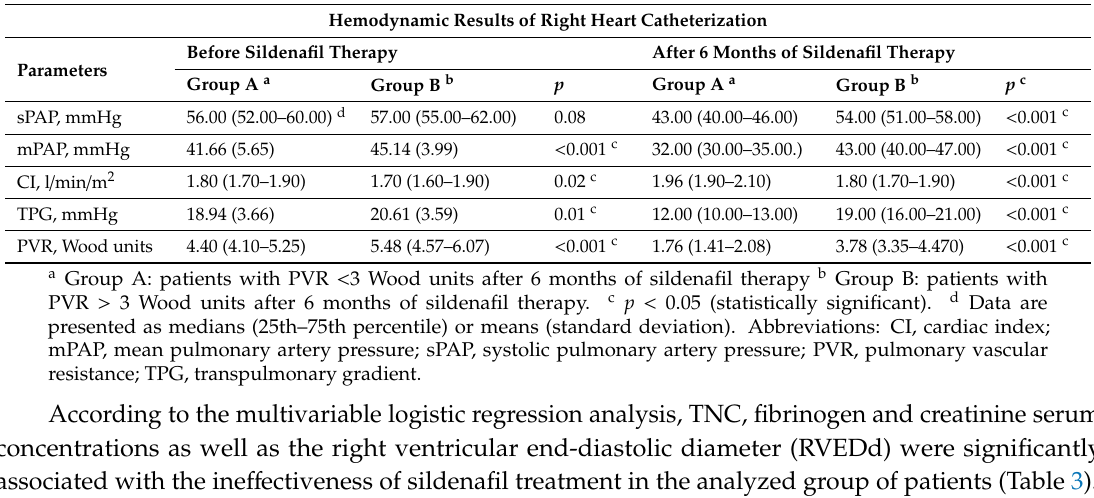
Table 2. Hemodynamic results of right heart catheterization at the baseline and after 6 months of sildenafil therapy in Groups A and B.